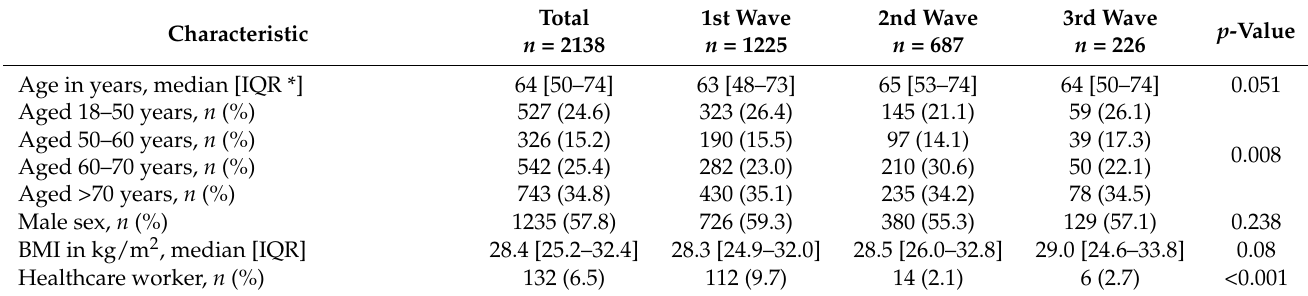
Table 1. Baseline characteristics and clinical data for patients hospitalized in the Hospital for Infectious Diseases in Warsaw due to COVID-19 during three pandemic waves from 2020 to 2021 in